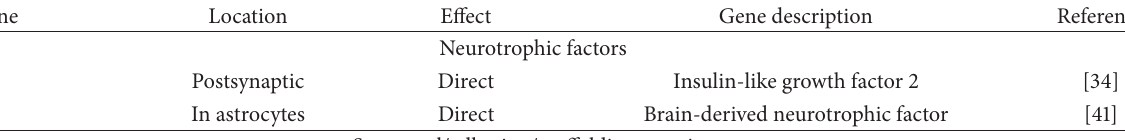
Table 1: Overview of NF- 𝜅 B target genes in synaptic